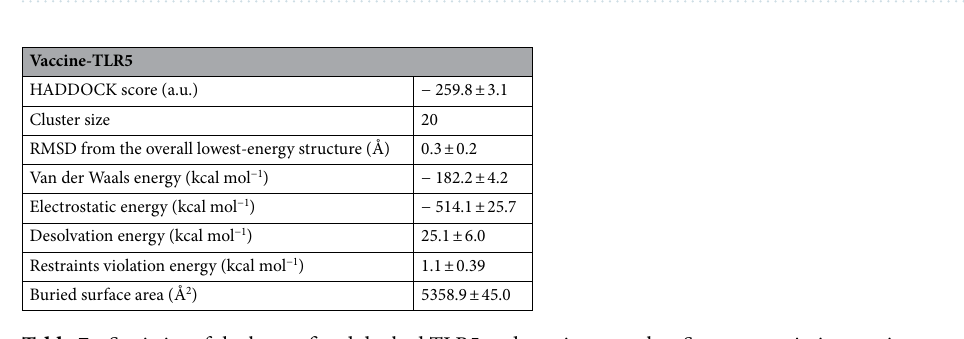
Table 7. Statistics of the best refined docked TLR5 and vaccine complex. Strong protein interaction expressed in arbitrary units (a.u.) is represented by smallest HADDOCK score.